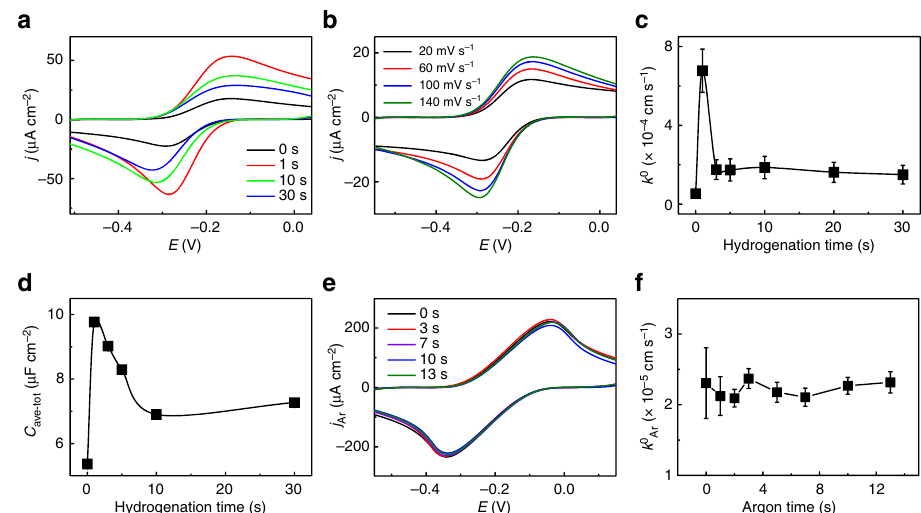
Fig. 3 Electrochemical behavior of CVD graphene upon hydrogenation. a Cyclic voltammograms (CVs) obtained on graphene after 0 – 30 s of hydrogenation at a scan rate of 100 mV s − 1 . b Current density vs scan rate for untreated graphene shown in a . c The electron transfer rate k 0 vs hydrogenation time from 0 to 30 s. d The averaged total capacitance C ave − tot vs hydrogenation time from 0 to 30 s. e CV curves obtained on graphene after 0 – 13 s of Ar treatment at a scan rate of 100 mV s − 1 . f k 0 vs argon plasma treating time from 0 to 13 s. The aqueous electrolyte solution contains 0.1 Ar M KCl supplemented with 10 mM Tris at pH 8. The redox probe employed is 1 mM hexaammineruthenium (II)/hexaammineruthenium (III) chloride. The error bars in c , d , f are the standard deviation of experimental